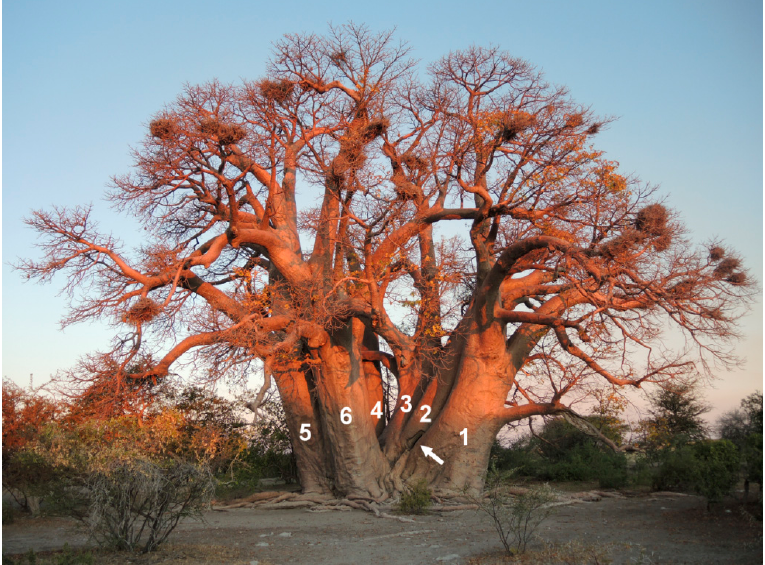
Figure 1. Main view of the Chapman baobab taken from the west (June 2015). The six stems are numbered (1–6). The cavity entrance is also shown (see arrow).